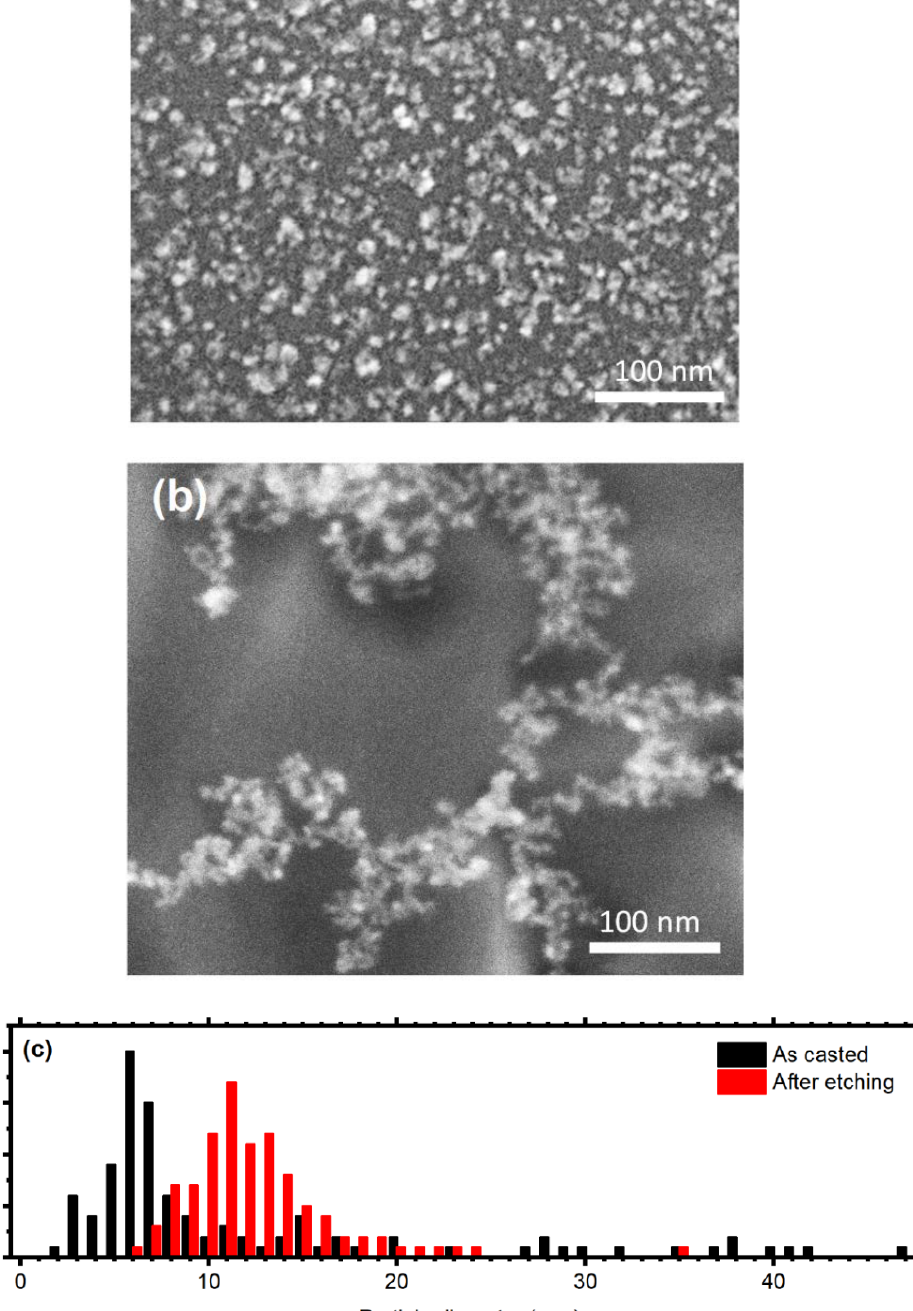
Figure 2. SEM micrographs showing Au nanoparticles on the GaAs surface as casted ( a ) and after the etching process. ( c ) Particles size distribution before (black) and after ( b ) GaAs MacEtch.